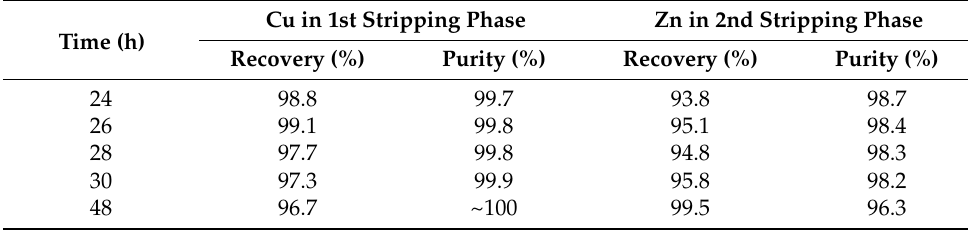
Table 2. Metal recovery and purity of the stripping phases over